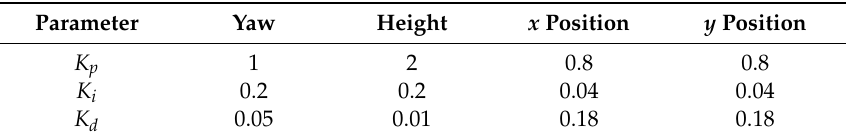
Table 2. The values of parameters of the proportional-integral-derivative